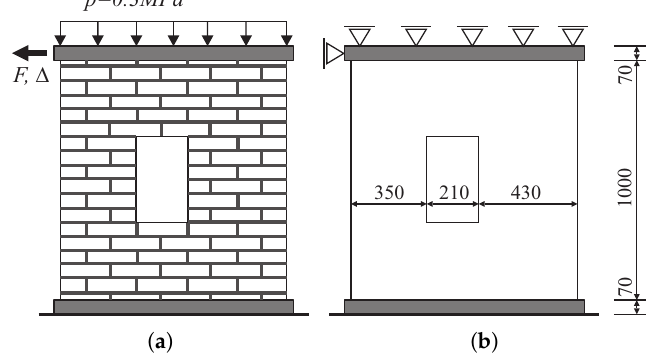
Figure 13. Walls tested by Raijmakekers and Vermeltfoort [43]: ( a ) load scheme for shear walls, ( b ) geometry and static sheme for numerical analysis.